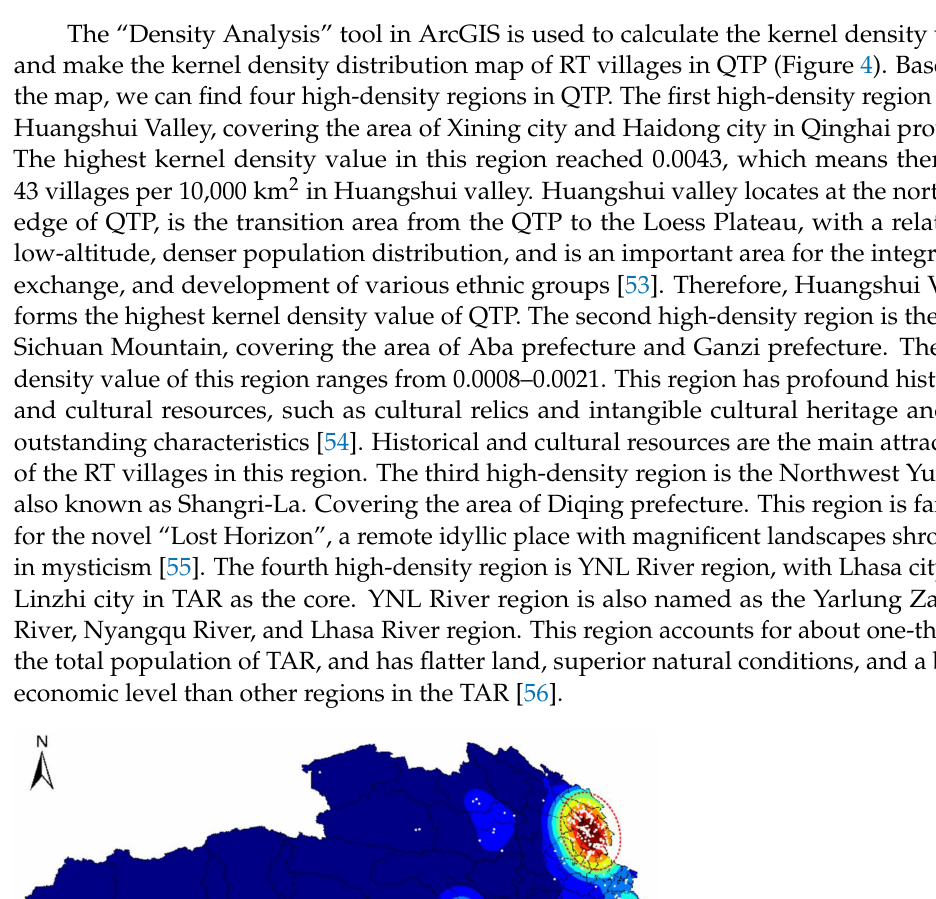
Figure 3. Lorenz curve of RT villages in QTP.